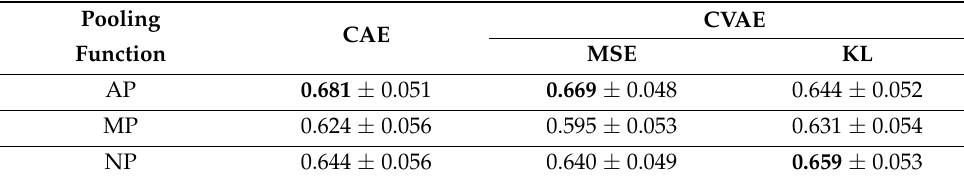
Table 12. Average of the per-patient ROC AUC scores for the discrimination between sessions that correspond to stable, or anomalous (pre-relapsing or relapsing) condition, for both CVAE and CAE personalized models. Pooling